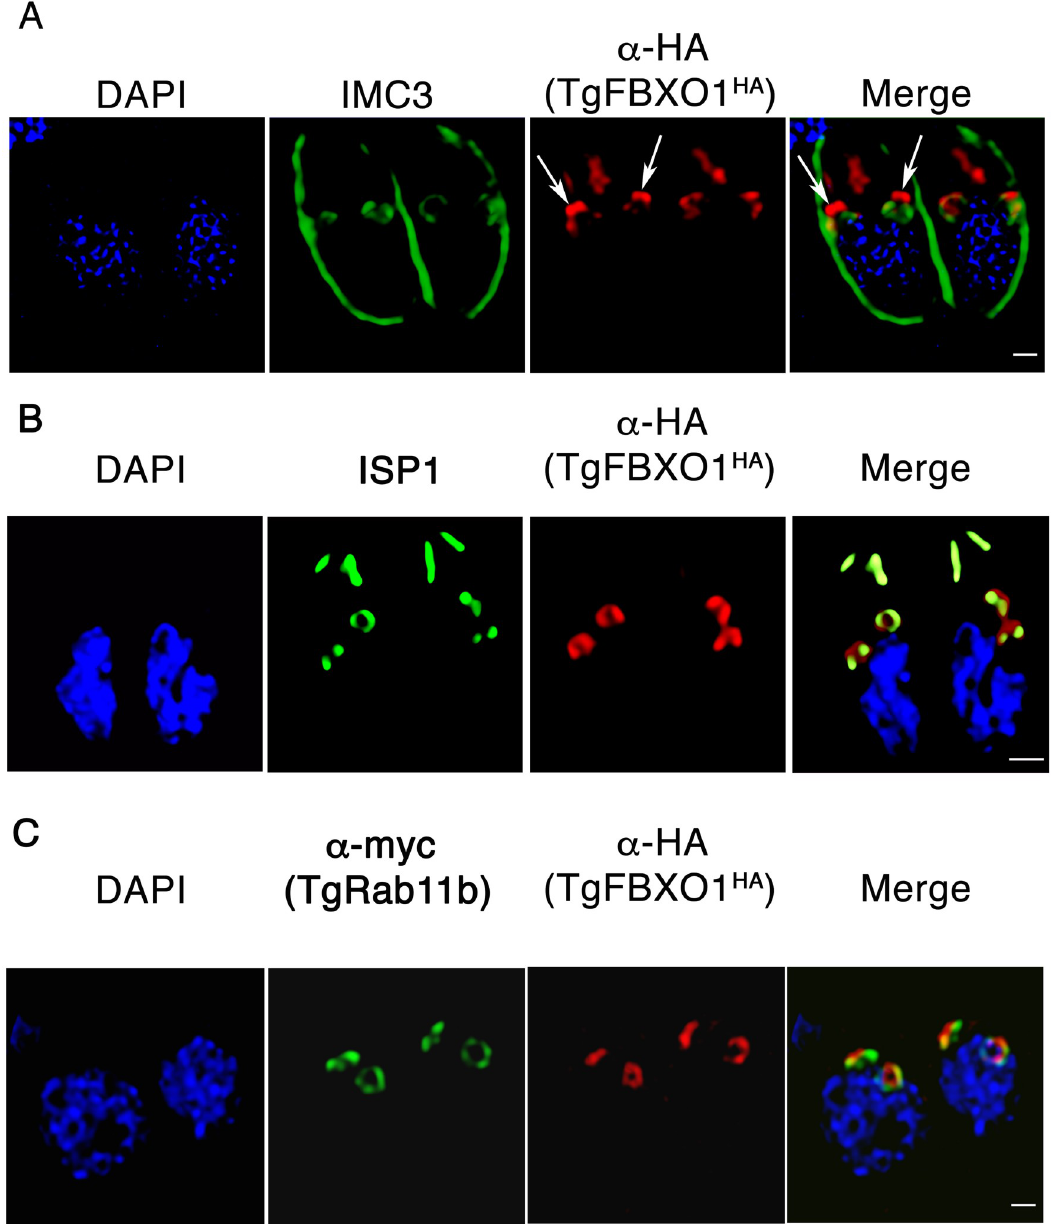
Fig 8. Super resolution microscopy imaging of TgFBXO1. TgFBXO1 HA parasites were fixed and imaged using Hyvolution Acquisition Software to detect TgFBXO1 and IMC3 (A), ISP1 (B), and TgRab11b (C). Shown are still images from movies of three dimensional projections available as supplemental